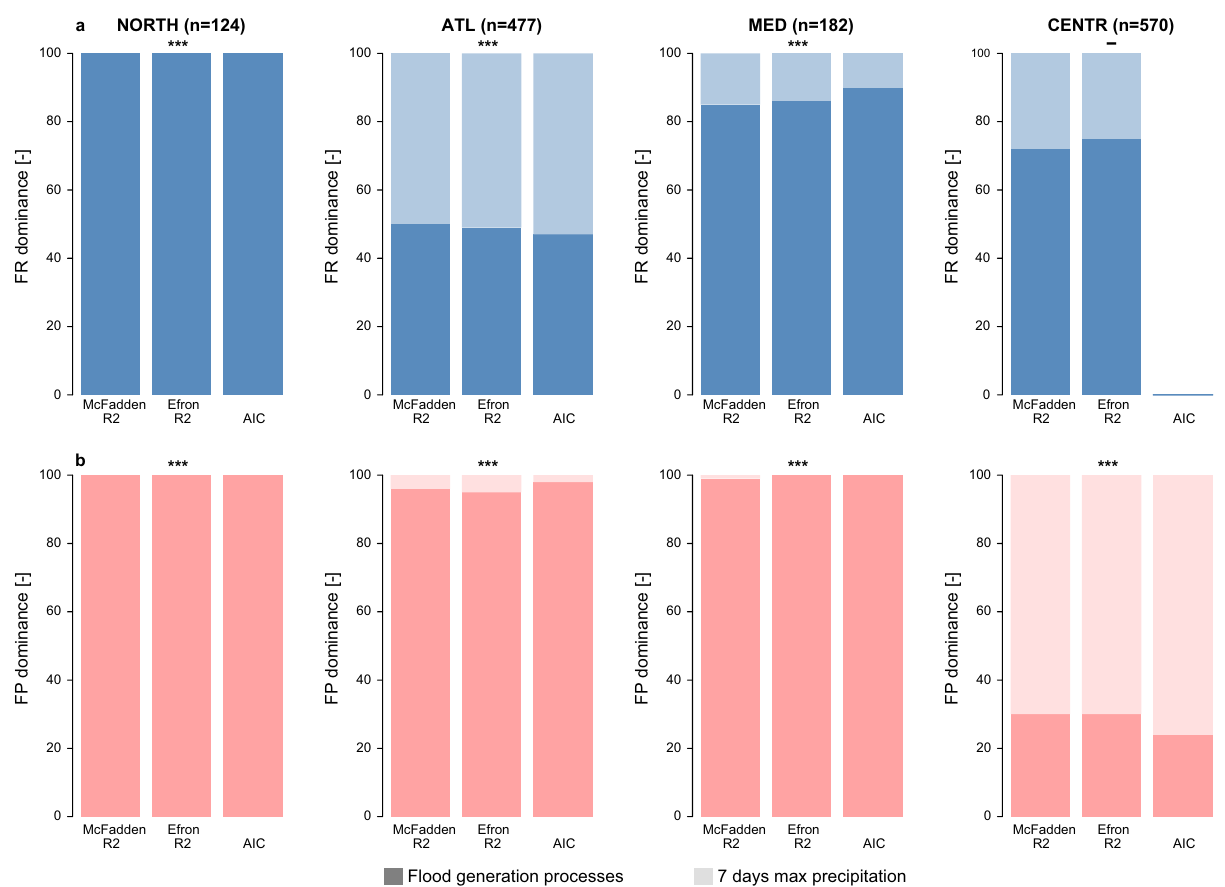
Fig. 5 General dominance (additional contributions) of temporal variation in fl ood generation processes and extreme precipitation for predicting the probability of occurrence of regional fl ood anomalies using binomial generalised linear models. Importance of fl ood generation processes and 7 days precipitation maxima for fl ood anomalies ( a fl ood-rich periods (FR); b fl ood-poor periods (FP)) in terms of various performance metrics (McFadden R 2 , Efron R 2 and Akaike Information Criterion (AIC), see Table 1). Higher value of dominance indicates higher contribution to the respective performance measure. The dominance in terms of the AIC is only displayed if the full model (i.e., including the fl ood generation processes and the extreme precipitation) improves in terms of information content compared to the baseline model that only uses the intercept (i.e., AIC baseline -AIC full is higher than 2, see Table 1). Signi fi cance of the covariates ( p < 0.01 (***), p < 0.05 (**), p < 0.1 (*), p > 0.1 (-)) is provided for each region and anomaly on the top of the corresponding plot. n indicates the number of catchments considered in each